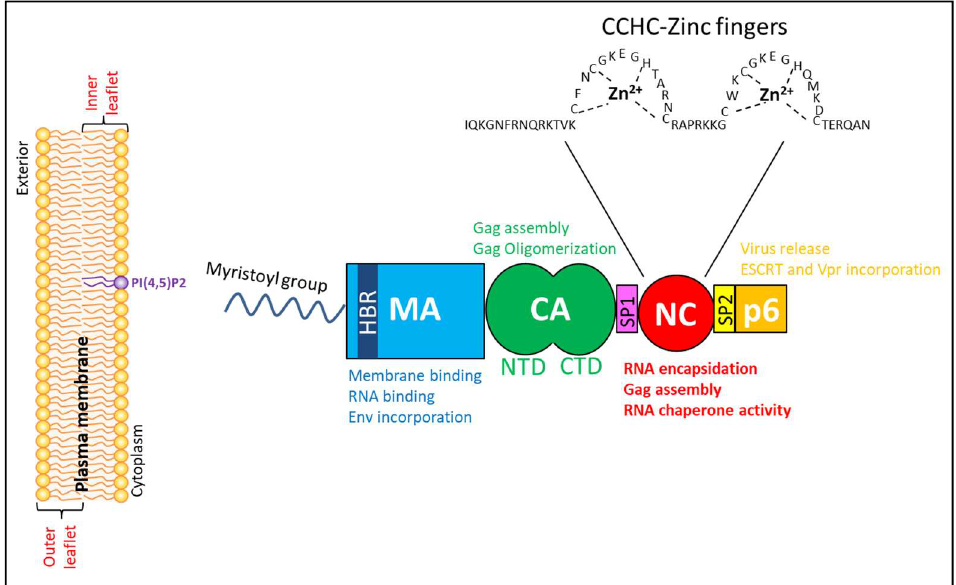
Figure 1. Schematic representation of the human immunodeficiency virus (HIV-1) Group-specific antigen (Gag) polyprotein, its different domains and their functions. HIV-1 Gag comprises different domains: matrix (MA), capsid (CA), nucleocapsid (NC), p6 and two spacer peptides (SP1 and SP2). The plasma membrane and phospholipid phosphatidylinositol 4,5-bisphosphate (PI(4,5)P2) located in the inner leaflet are indicated. Gag contains a myristoyl group at its N-terminal end (represented by the blue wave). The nucleocapsid (NC) is a characterized by two highly conserved zinc fingers separated by a basic linker.